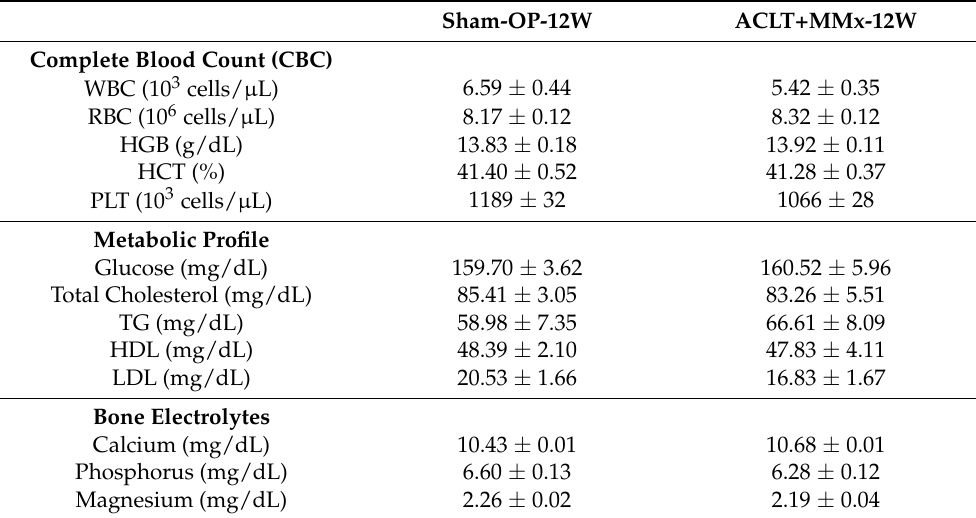
Table 1. Total blood composition and biochemical profile of sham-OP and ACLT+MMx-induced osteoarthritis (OA) rats (12th